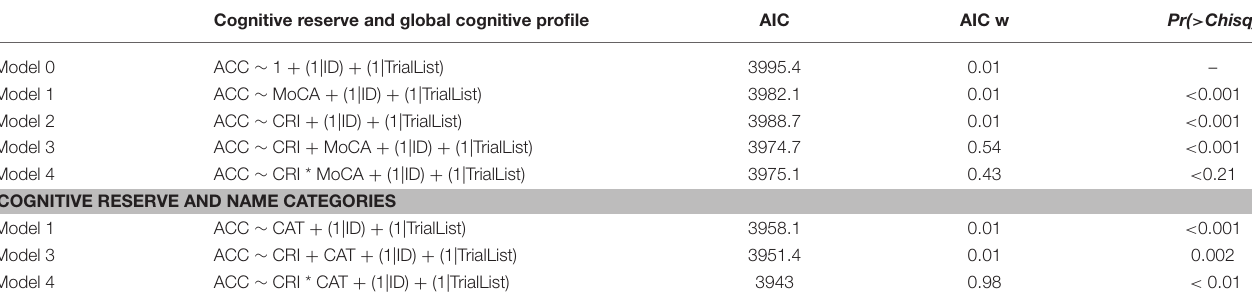
TABLE 3 | Generalized Linear Mixed-Effects Models with name retrieval Accuracy as dependent variable. Cognitive reserve and global cognitive